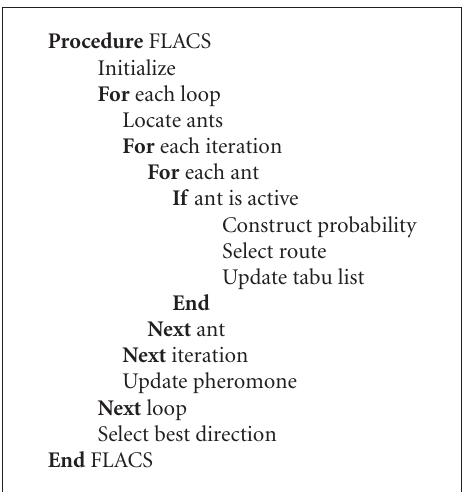
Algorithm 1: Proposed FLACS algorithm in